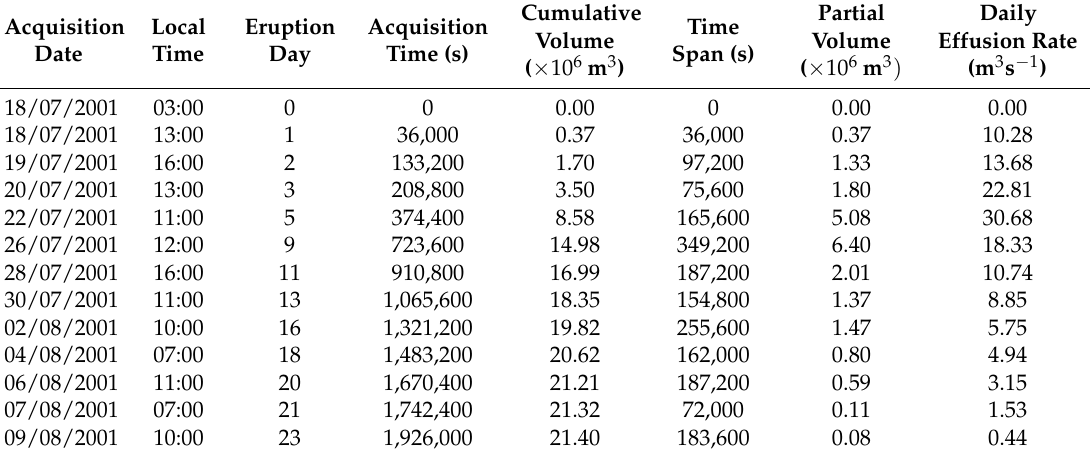
Table 2. Volumes and effusion rates for the LFS1 2001 Mount Etna eruption (from